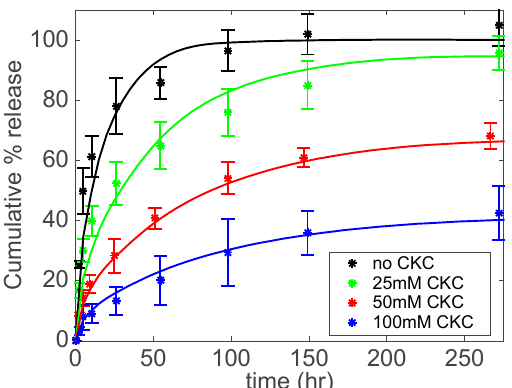
Figure 5. DFNa cumulative % release as a function of time under different CKC concentrations. Catanionic aggregates were prepared at a fixed concentration of DFNa (30 mM) and Brij 97 (20 wt%). Total amount of drug per lens: 119.7 ± 8.7 µg for No CKC; 142.6 ± 13.2 µg for 25 mM CKC; 120.0 ± 12.4 µg for 50 mM CKC; 134.3 ± 18.5 µg for 100 mM CKC. Data are presented as mean ± standard deviation with n = 3.